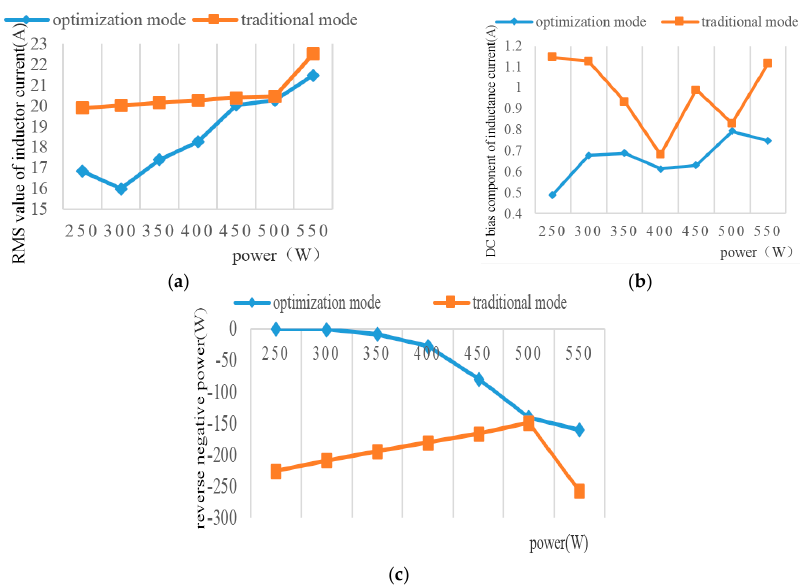
Figure 10. Three contrastive curves according to Table 3. ( a ) Comparison of RMS value of inductor current; ( b ) Comparison of DC bias component of inductance current; ( c ) Comparison of reverse negative power.